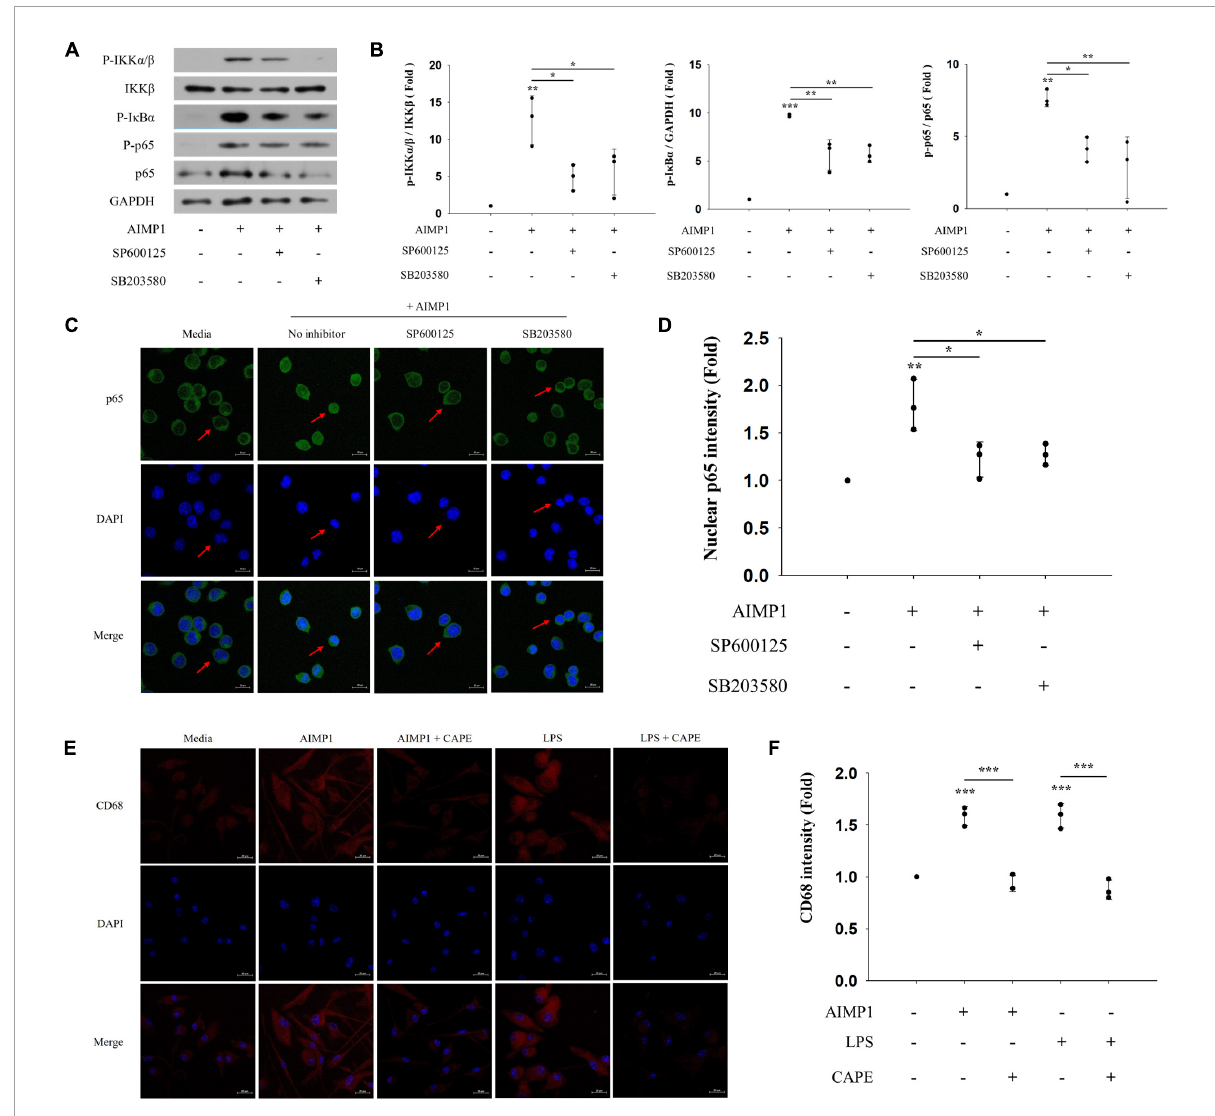
FIGURE5 c-Jun N-terminal kinase (JNK) and p38 act as upstream regulators of NF- κ B during AIMP-induced microglial activation Following pretreatment with 1 µ M of the MAPK inhibitors (SP600125 and SB203580) for 30 min, BV-2 cells were treated with AIMP1 (250 nM) for 40 min (A,B) or 1 h (C,D) . (A) IKK β , p65, and phosphorylated forms of IKK α / β , I κ B- α , and p65 were quantified using western blot analysis. GAPDH served as a control. (B) Scatter plots represent the phosphorylation ratio of NF- κ B proteins. It shows the mean ± SD of three independent experiments. (C,D) Transflocation of NF- κ B p65 into the nucleus was observed using confocal microscopy. (D) Scatter plots represent the fold ratio based on the fluorescence intensity of nuclear p65 in the medium group. It shows the mean ± SD of three independent experiments. (E,F) Following pretreatment with the NF- κ B inhibitor (CAPE) for 30 min, the primary microglia were cultured with AIMP1 (250 nM) for 72 h. The expression of CD68 in the primary microglia was observed using confocal microscopy. The representative data are shown. (F) Scatter plots represent the fold ratio based on the fluorescence intensity of CD68 in the medium group. It shows the mean ± SD of three independent experiments. Statistical significance was evaluated using one-way ANOVA with a Bonferroni post hoc test for multiple comparisons; * P < 0.05, ** P < 0.01, and *** P < 0.001 compared to the medium